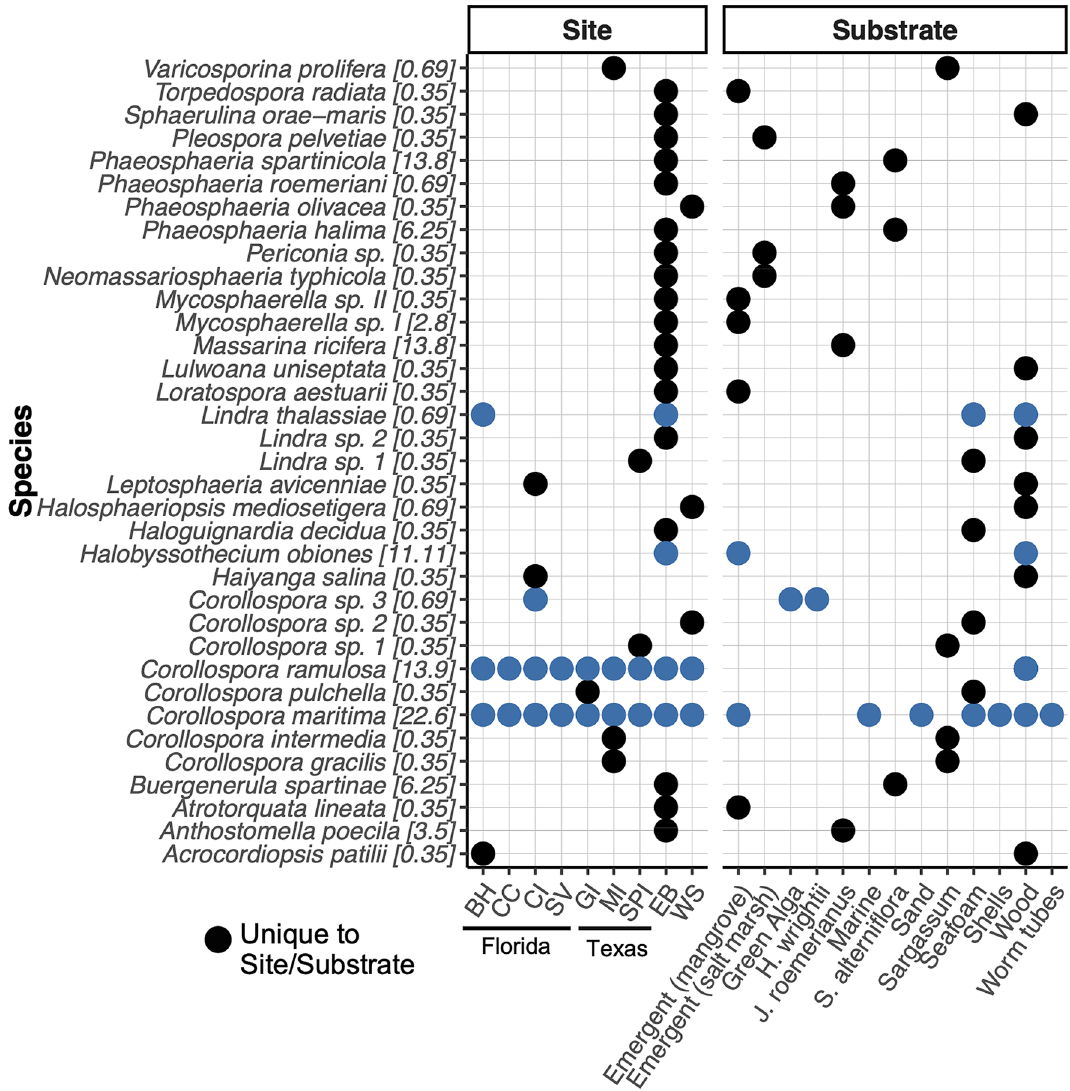
Figure 3. Overview of fungi detected morphologically on intertidal substrates of the U.S. Gulf of Mexico by site (left panel) and substrate-type (right panel). Substrate type ‘marine’ includes unidentified seagrass and algae. Substrate type ‘Emergent (salt marsh)’ includes salt marsh plant detritus not identifiable to host plant species. The relative frequency of occurrence for fungal taxa in all collections housing sporulating fungi ( n = 288) as detected morphologically is provided in brackets next to taxon labels. For location and further description of sites see Fig. 1 and Supplementary Table S4. Collections occurred weekly at East Beach, Mississippi (EB); collections occurred bimonthly at West Ship Island, Mississippi (WS) and once per winter and per summer for the remainder of sites. Taxonomic authorities are provided in Supplementary Table S1.